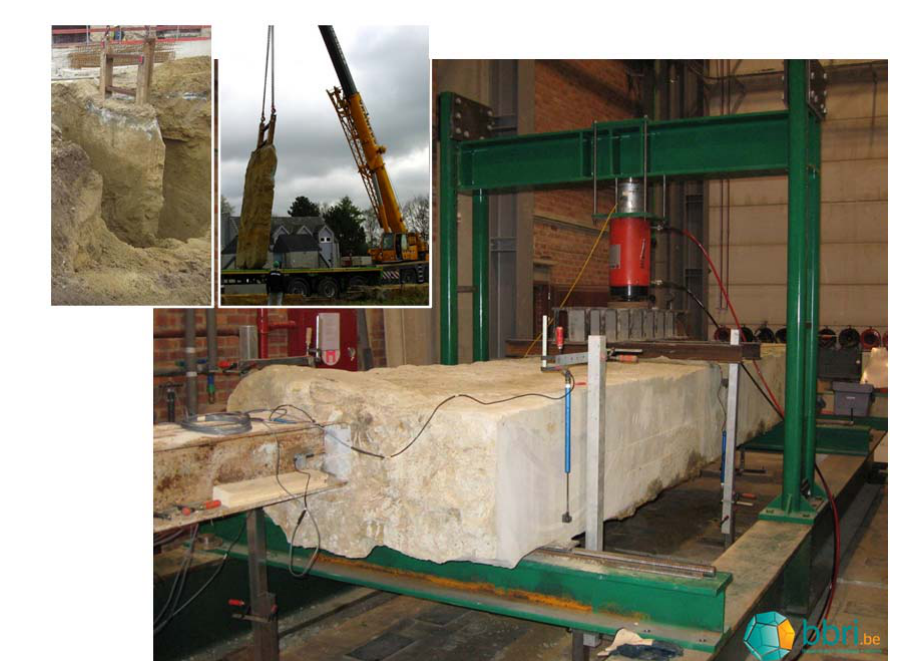
Figure 5. Large ‐ scale bending tests performed on real ‐ scale soil mix elements (columns or panels) within the framework of the BBRI Soil Mix project (2009 ‐ 2013) [24, 25]. Table 3. Bending moment in a temporary soil mix panel (thickness 55 cm) reinforced with steel beams (type HEA – steel grade S235). Resistance of the soil mix wall in terms of bending moment (kN/L eff γ